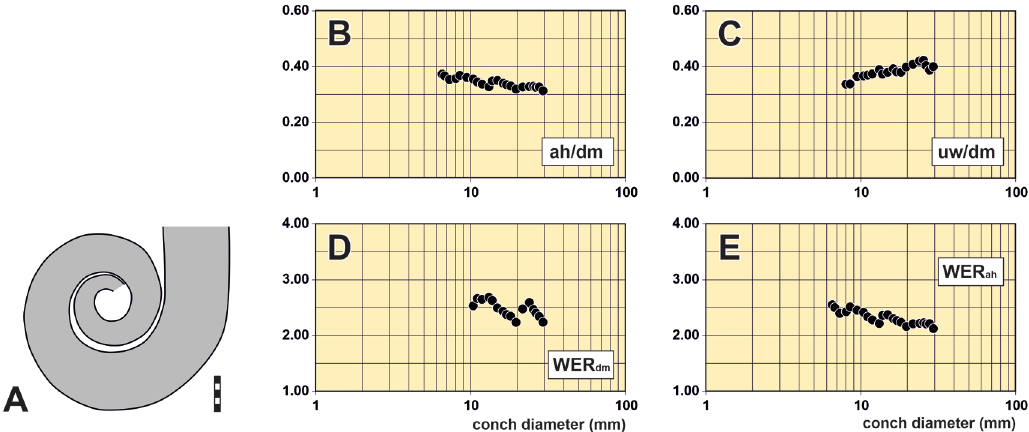
Fig. 51. Lituites tenuicaulis Remelé, 1890. A . Outline of coiled conch part of specimen MB.C.30548. B–E . Conch proportions and coiling rates of specimen MB.C.30548. Scale bar units = 1 mm.